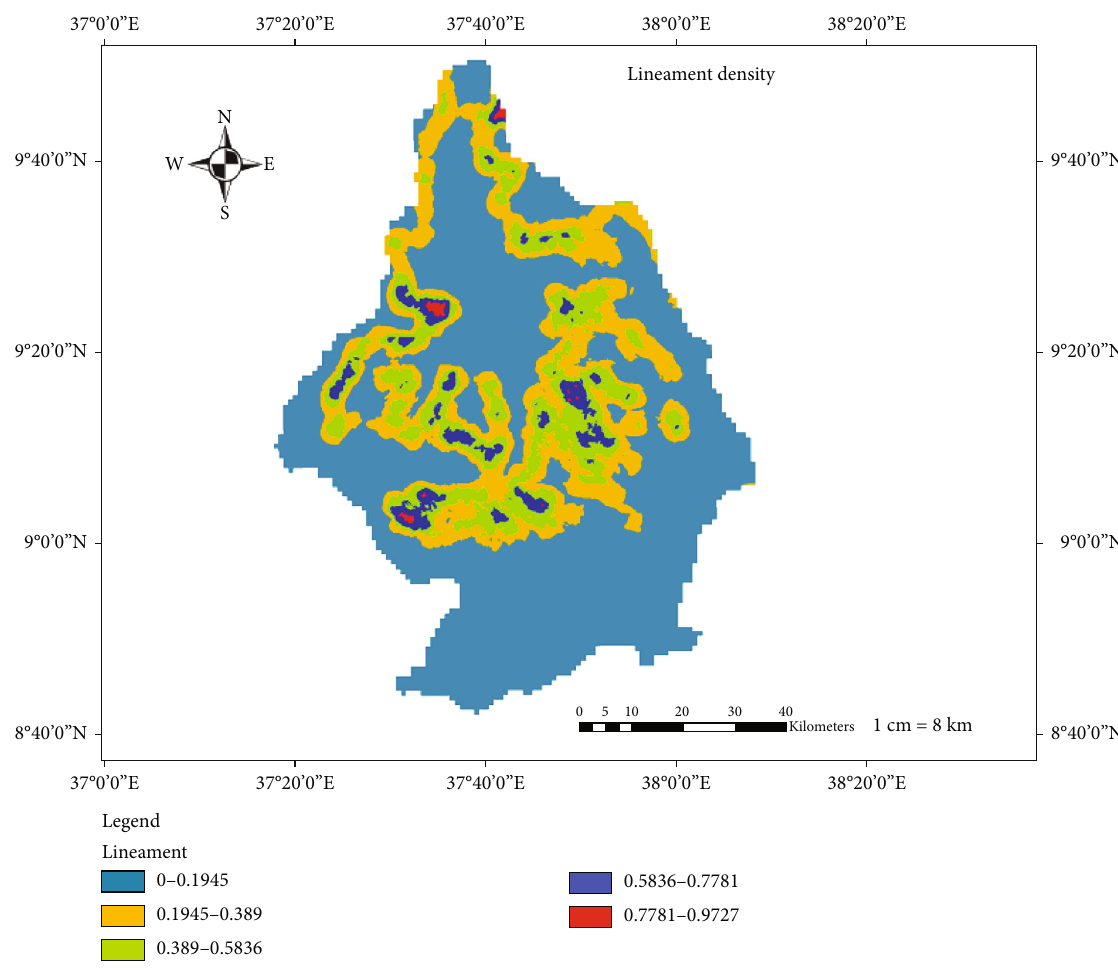
Figure 11: Lineament density map of the study